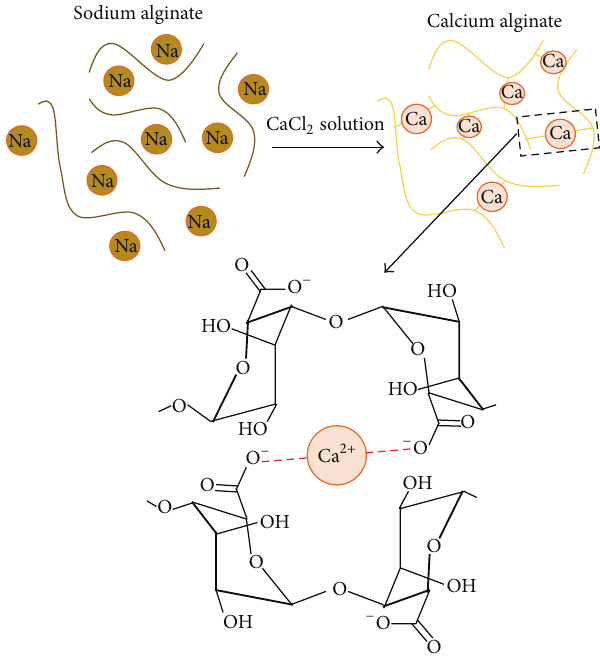
Figure 2: Reaction of SA and CaCl 2